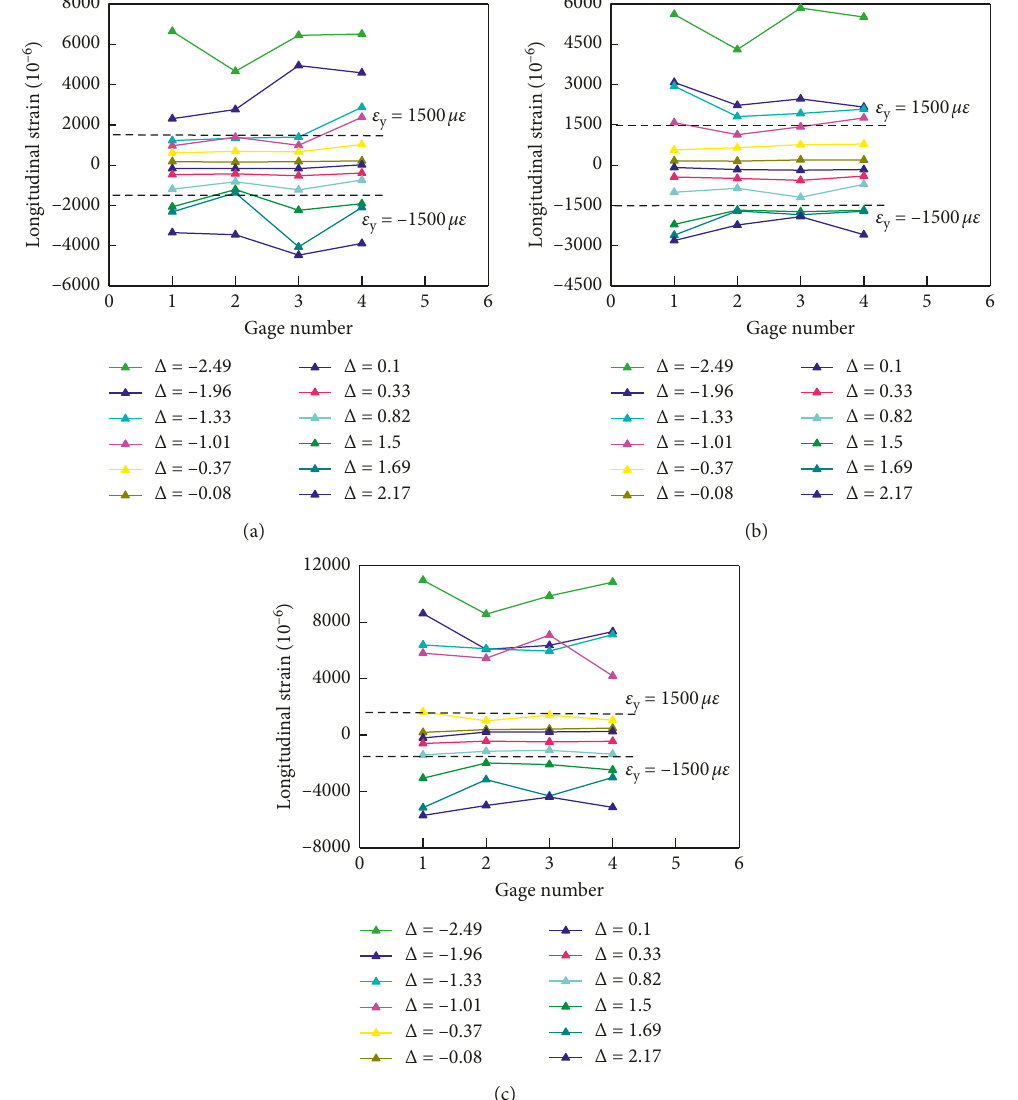
Figure 8: Longitudinal strain. (a) Loading end; (b) constraint end; (c) central section of the